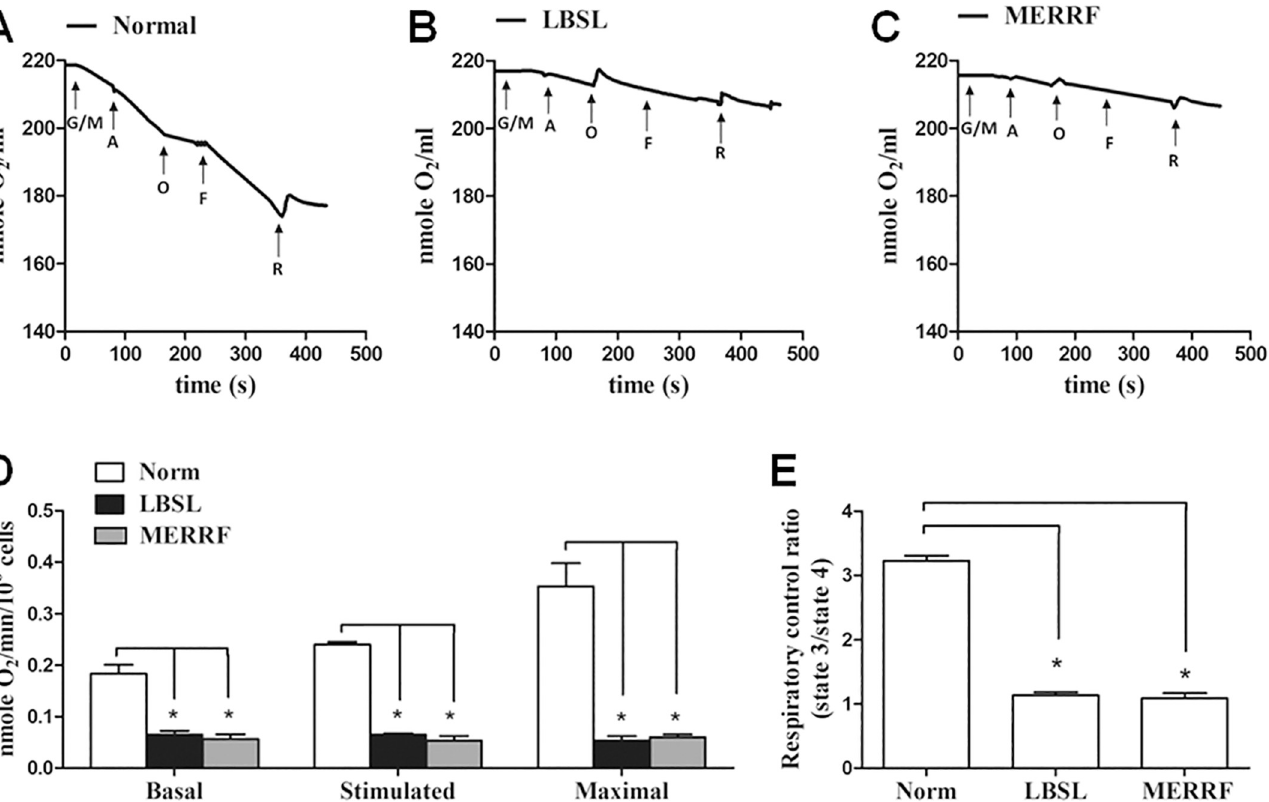
Fig 3. DARS2 defect causes respiratory dysfunction of mitochondria. (A, B and C) Representative results of polarographic data. Cells resuspended in oxymeter were sequentially loaded with indicated drugs to dissect respiratory capacity. G/M, glutamate and malate. A, ADP. O, oligomycin, F, FCCP. R, rotenone. (D) Basal, ADP-stimulated and FCCP-activated maximal respiration rate. (E) Respiratory control ratio calculated from ration of state 3 to state 4 respiration rate. State 3 and state 4 were defined as oxygen consumption under ADP and oligomycin, respectively. � p < 0.05 between indicated groups.